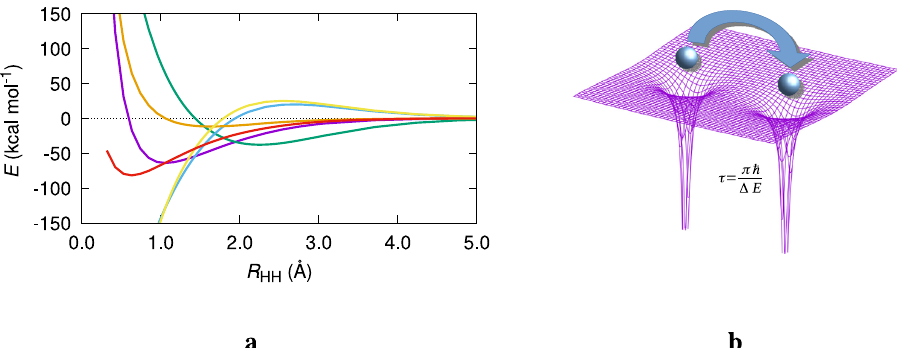
along with several of the energetic descriptors obtained by decomposing the space in Fig. 1 Bonding in H þ . a FCI cc-pVTZ potential energy curve of H þ 2 2 two symmetric regions associated to the a and b nuclei. All energies referred to their in fi nite distance limit, in a.u. E (purple), T (green), and V (cyan), stand for the full system's total, kinetic, and potential, energies, respectively. E int (orange) is the sum of the internuclear repulsion energy and the attraction energy of the electron density contained in the a region with the b nucleus, and vice versa. Similarly, V en 0 (yellow) is the sum of the attraction energy between the electron density in a with nucleus a and its b equivalent. Finally, E self (red) is the sum of the self-energies of the two regions, see the text, where it is also explained that in the broken symmetry spatial interpretation, V en 0 and E self can also be interpreted as those of a non-entangled H atom interacting with a proton. b Illustration of Feynman's dynamic picture of the 2c,1e bond. τ and Δ E are the inter-well tunneling rate and the system's fi rst excitation energy, respectively.